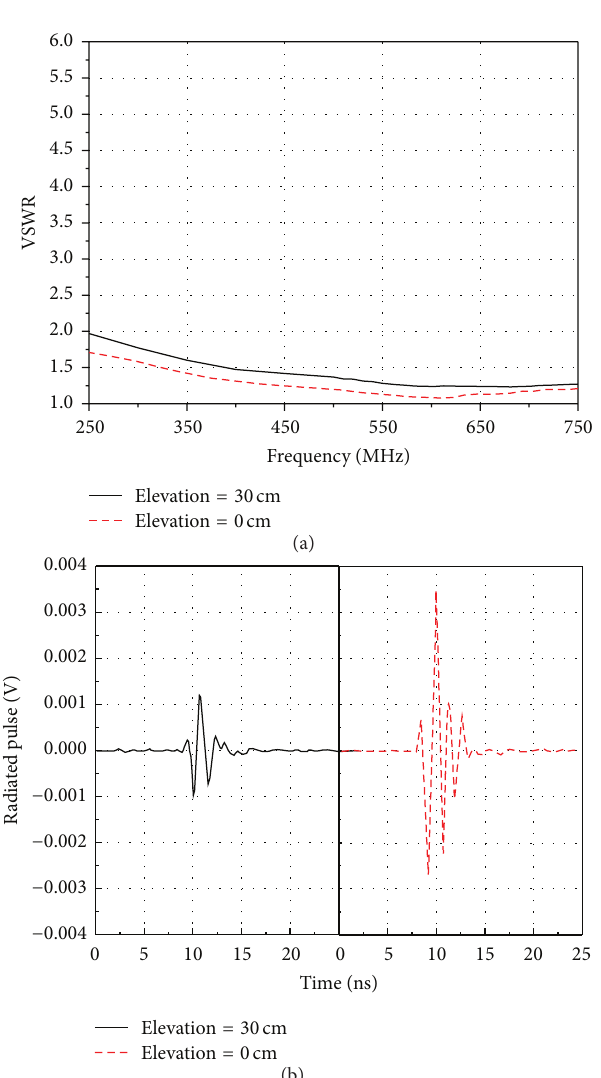
Figure 8: Comparison of the antenna with different elevation above the ground: (a) VSWR; (b) radiated waveform.